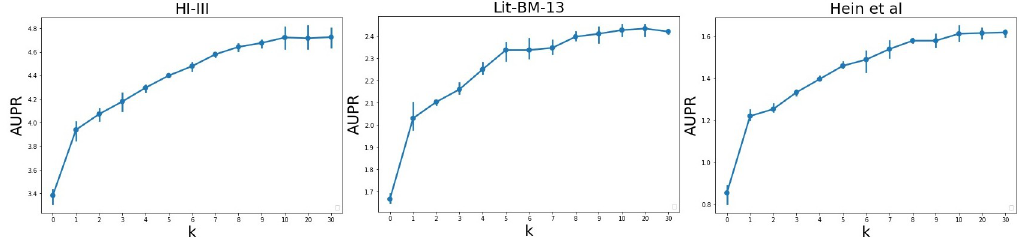
Fig 5. The prediction performance for different power iteration steps K on three human PPI networks ( α = 0.1).